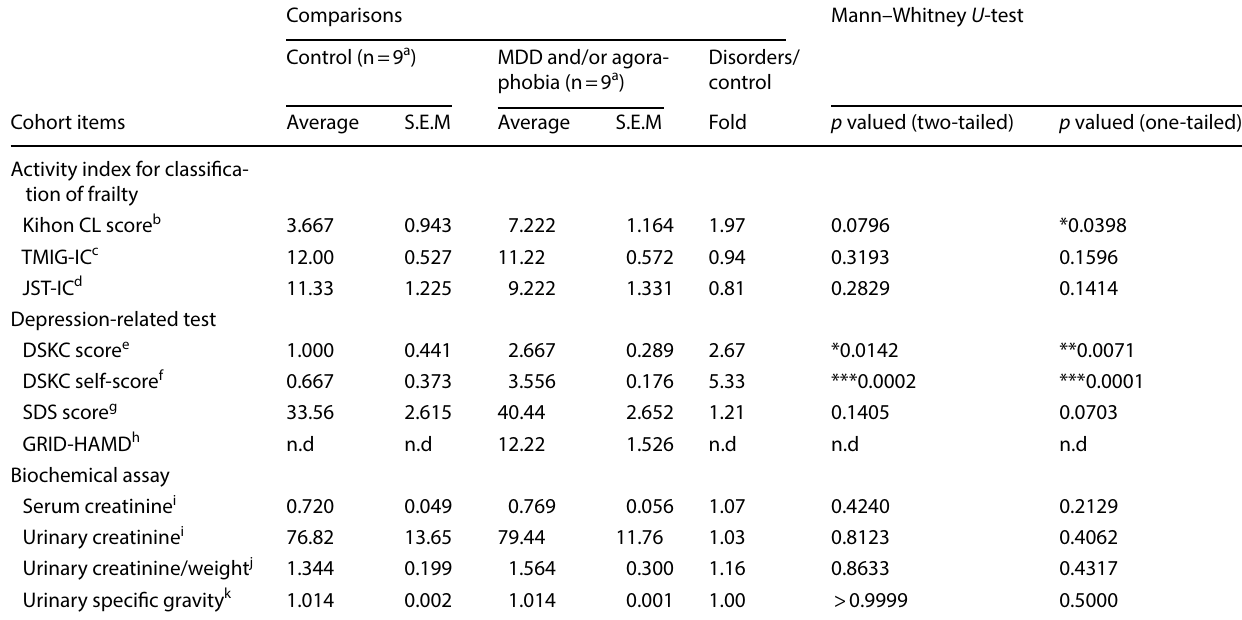
Table 1 Comparisons of the cohort items between persons negative and positive for major depressive disorder and/or agoraphobia disor-